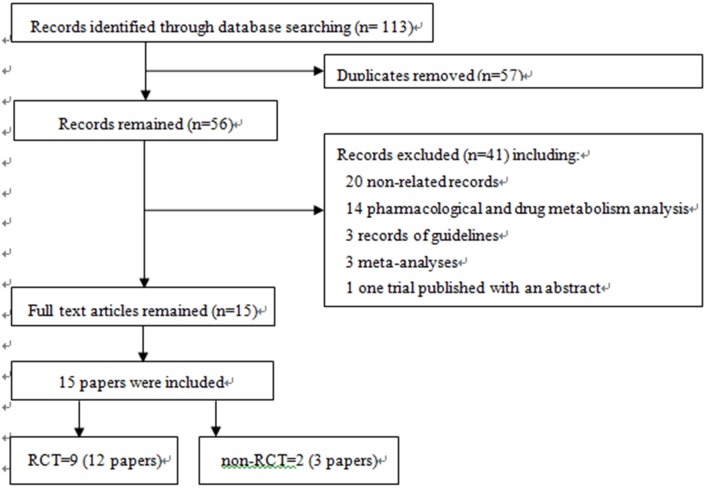
A flow diagram of the screening process.